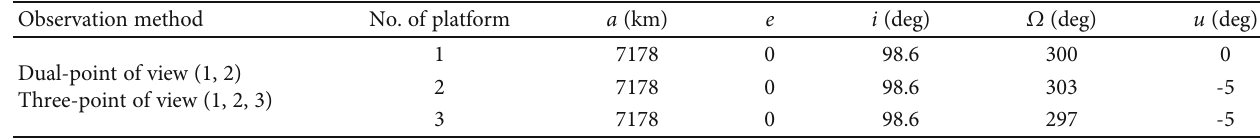
Table 2: The initial orbital elements of observation platforms.